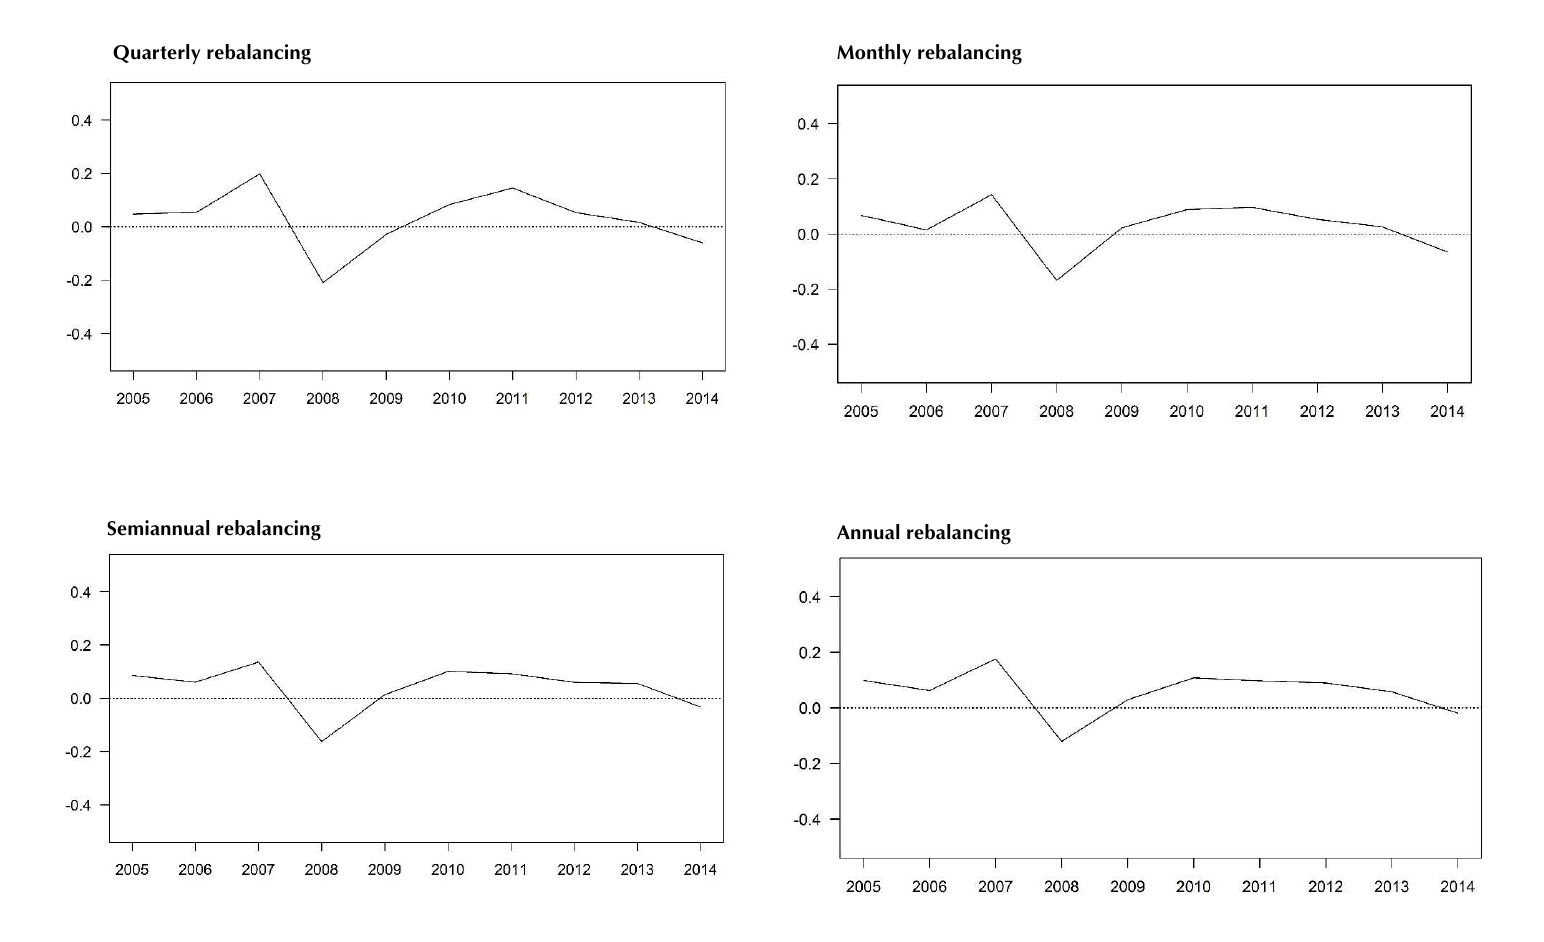
Figure 1. Excess return of mean-variance optimized